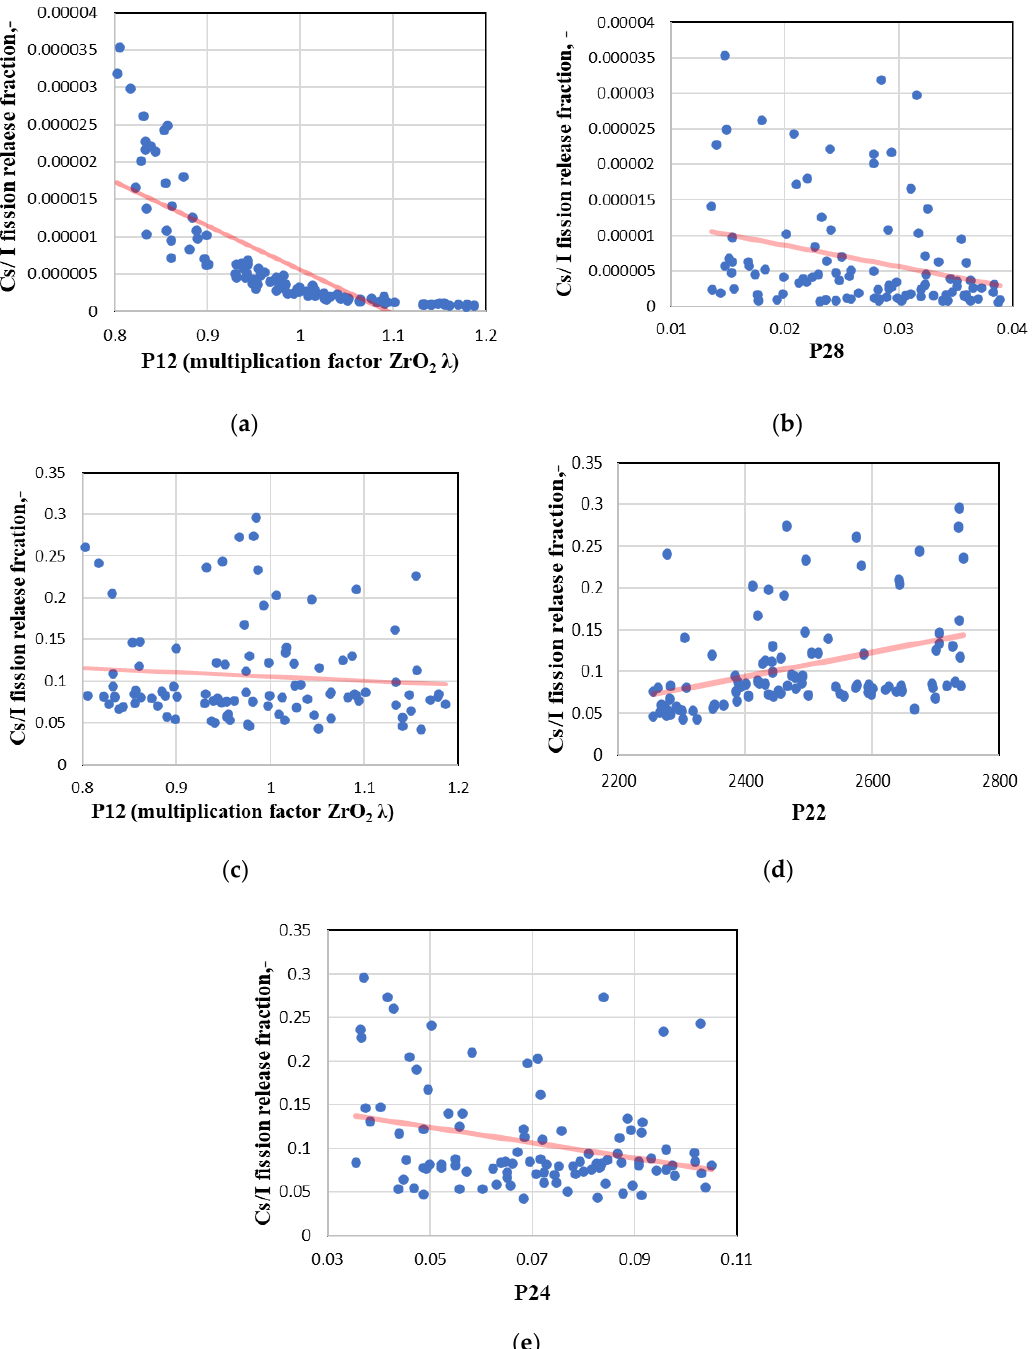
Figure 13. Scatter plots for Cs/I fraction. ( a ) P12 at pre-oxidation phase (9000 s); ( b ) P28 at pre-oxidation phase (9000 s);